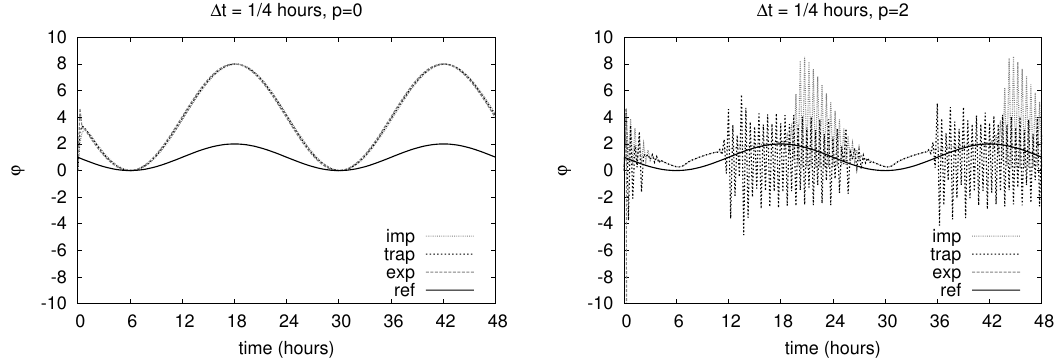
Fig. 3. The left figure shows the result of solving Eq. (1) (using scheme described by Eq. 2) with the fibrillation amplification test for the linear problem with p = 0, and the right figure shows the solution to the non-linear problem with p = 2 and time step 1t = 1 / 4h. The results are shown for implicit (dotted line), trapezoid (short dash line) and explicit (long dash line) schemes. Function D(t) is also shown (solid line) for reference.